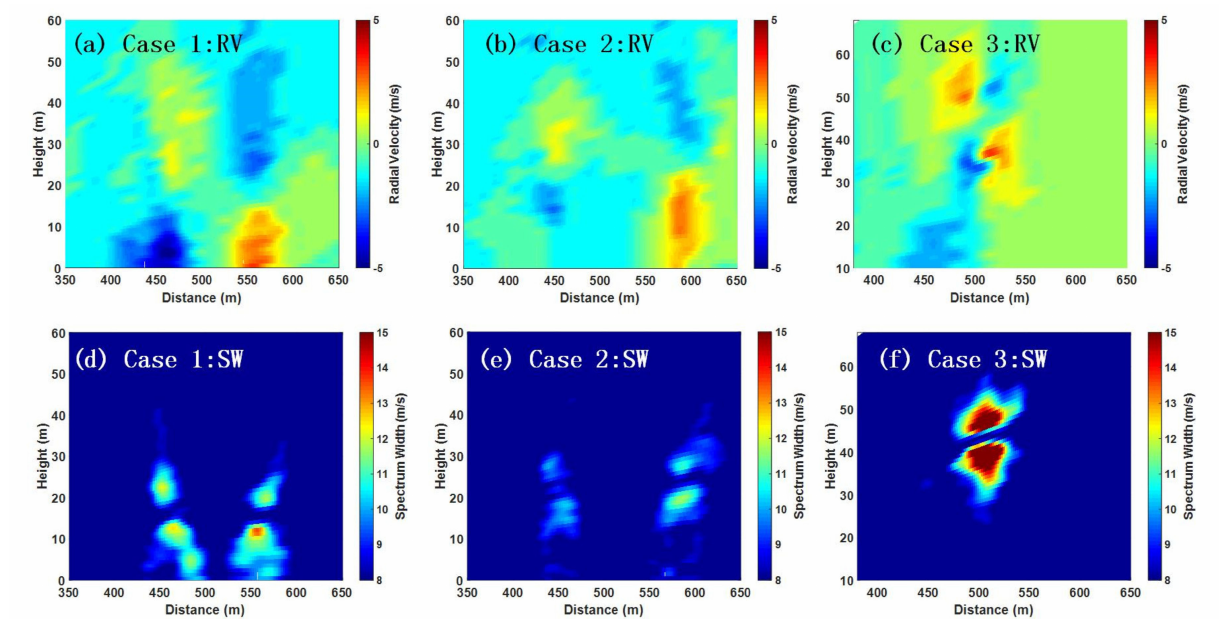
Figure 5. Wake vortex identification during different evolution phases. The radial velocity distribution of ( a ) B788 during vortex initial generation phase; ( b ) B788 during dissipation phase; ( c ) ARJ21 during vortex initial generation phase. The spectrum width distribution of ( d ) B788 during vortex initial generation phase; ( e ) B788 during dissipation phase; ( f ) ARJ21 during vortex initial generation phase.